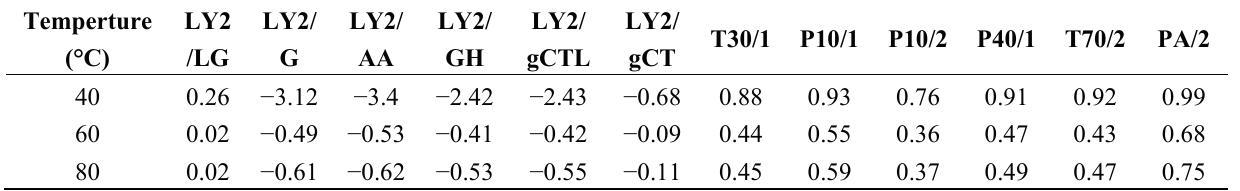
Table 3. The response intensity of sensors at different temperatures.